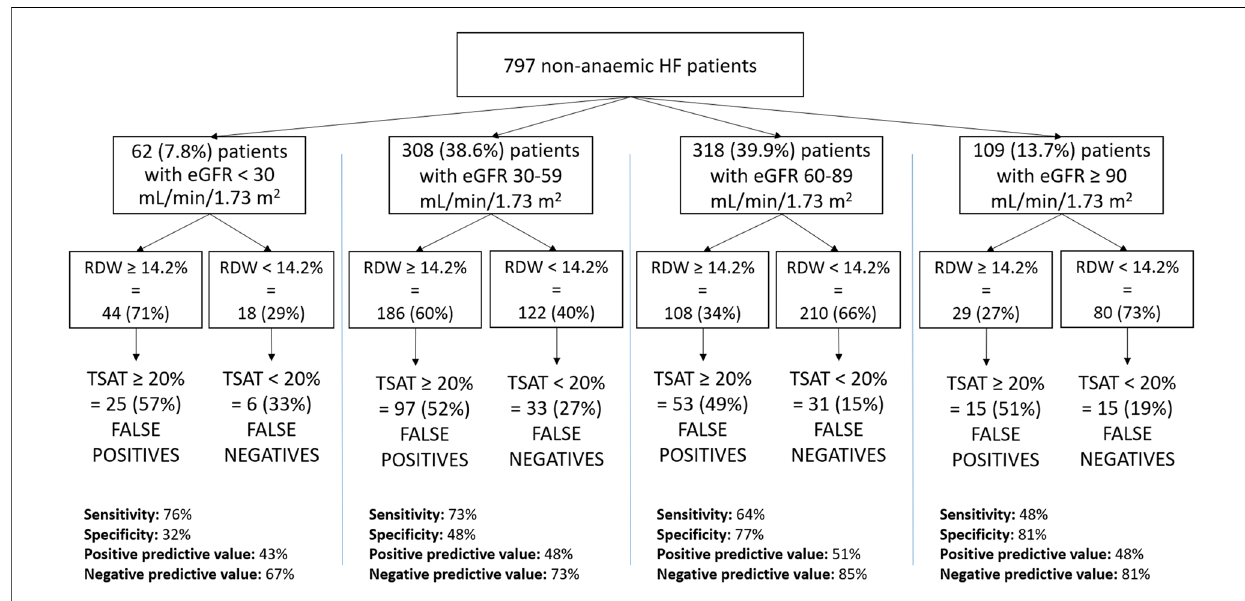
FIGURE 1 ( 1 ) ROC analysis of RDW, MCHC and MCV for the detection of IIT. IIT: impaired iron transport; MCHC, mean corpuscular haemoglobin concentration; MCV, mean corpuscular volume; RDW, red cell distribution width; ROC, receiver operating characteristic. ( 2 ) ROC analysis of RDW, RDW+MCHC and RDW+MCV for the detection of IIT. IIT, impaired iron transport; MCHC, mean corpuscular haemoglobin concentration; MCV, mean corpuscular volume; RDW, red cell distribution width; ROC, receiver operating